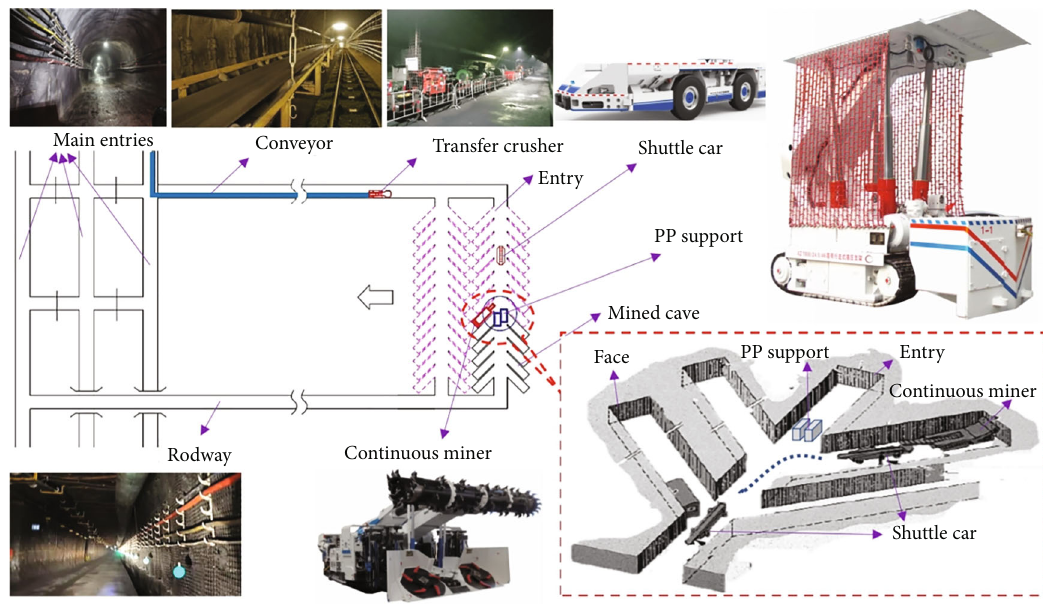
Figure 1: Arrangement of PP supports short-wall mining